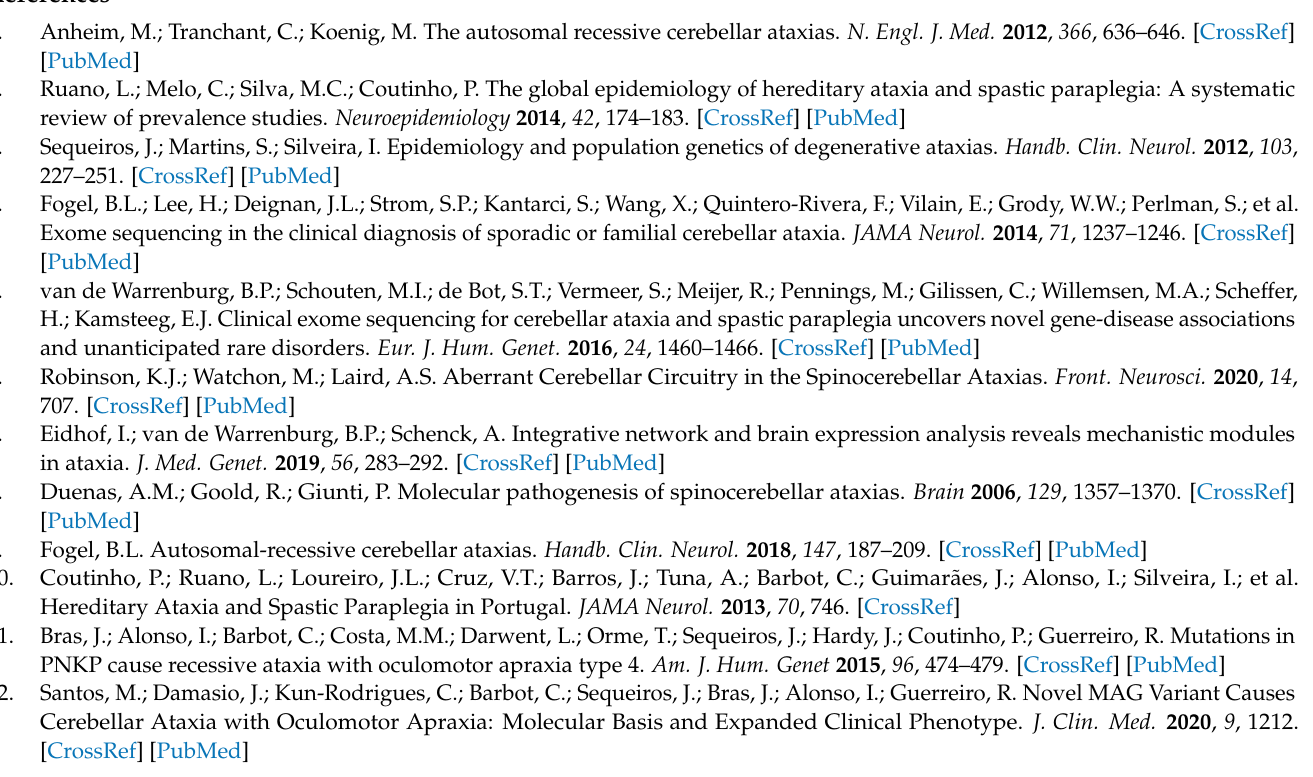
Table S5: RNA and protein expression data obtained from the Human Protein Atlas for genes and respective proteins identified in this study